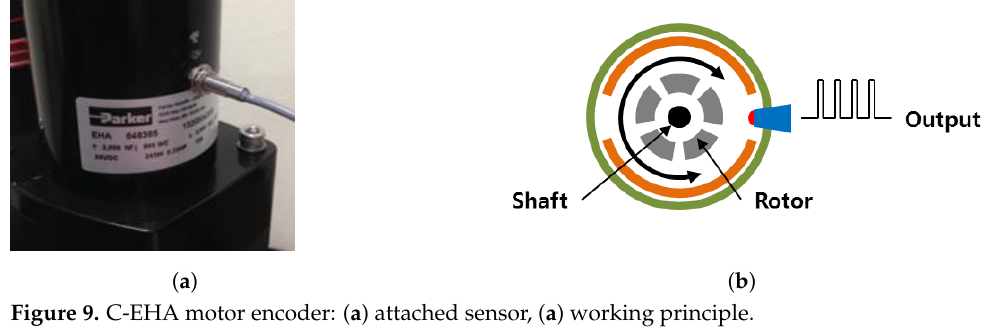
Figure 9. C-EHA motor encoder: ( a ) attached sensor, ( a ) working principle.